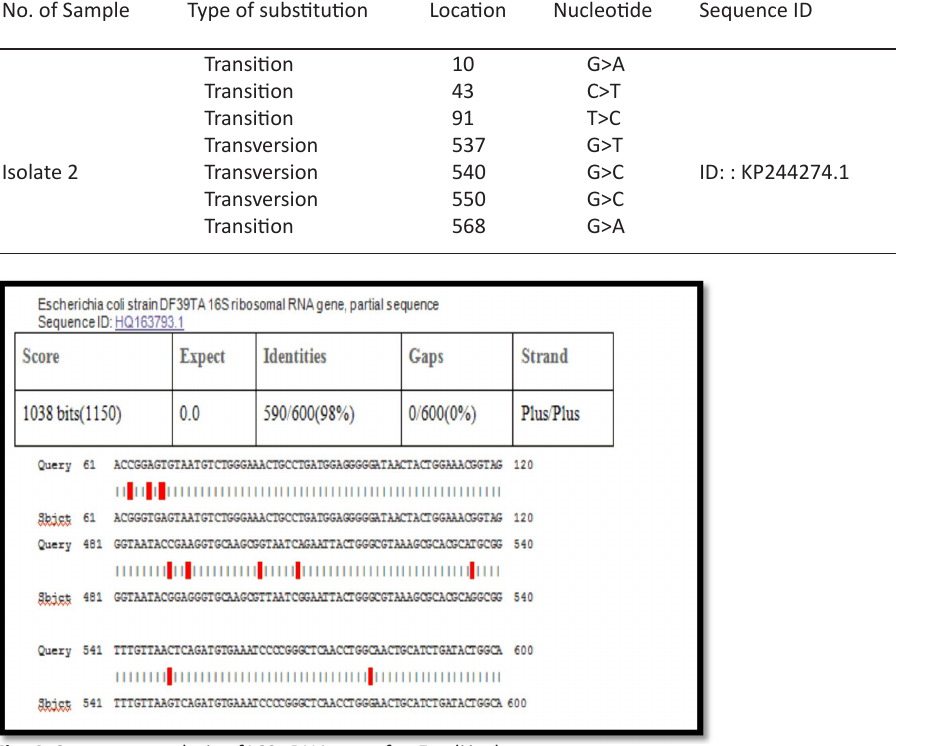
Fig. 4. Sequence analysis of16S rRNA gene for E.coli